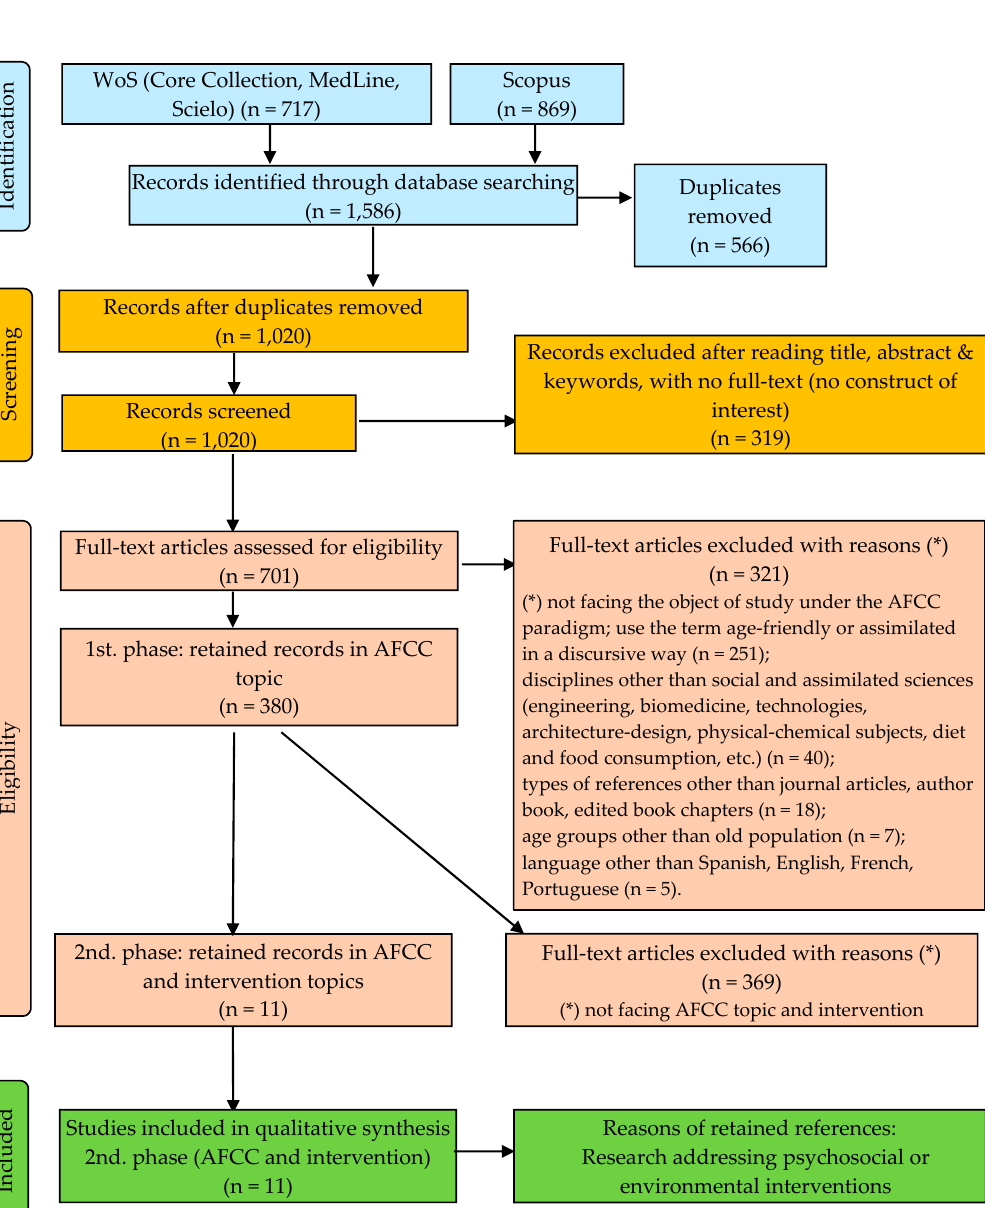
Figure 1. Flow of information through the different phases of the systematic review. WoS: Web of Science; AFCC: age-friendly cities and communities.